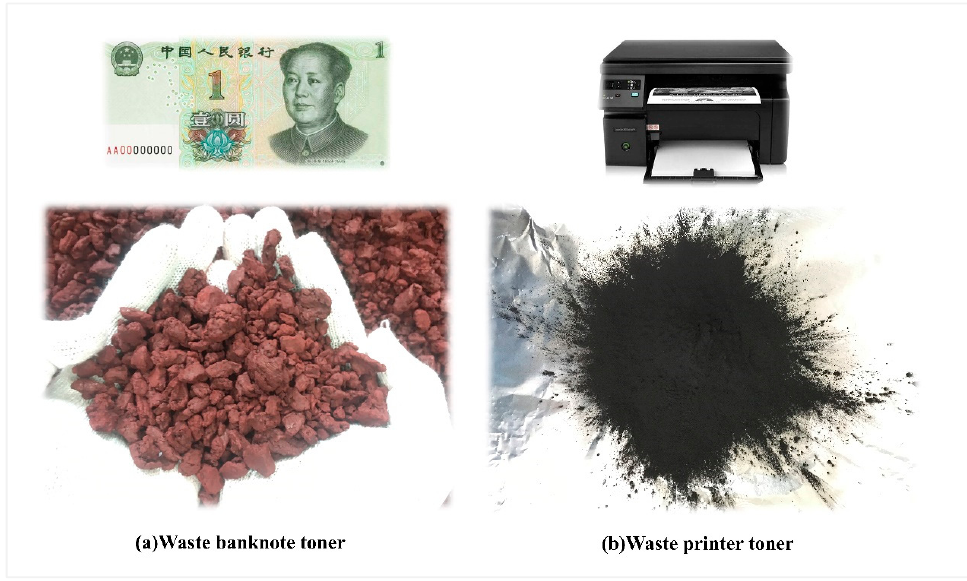
Figure 1. Appearance of waste toner modifiers.